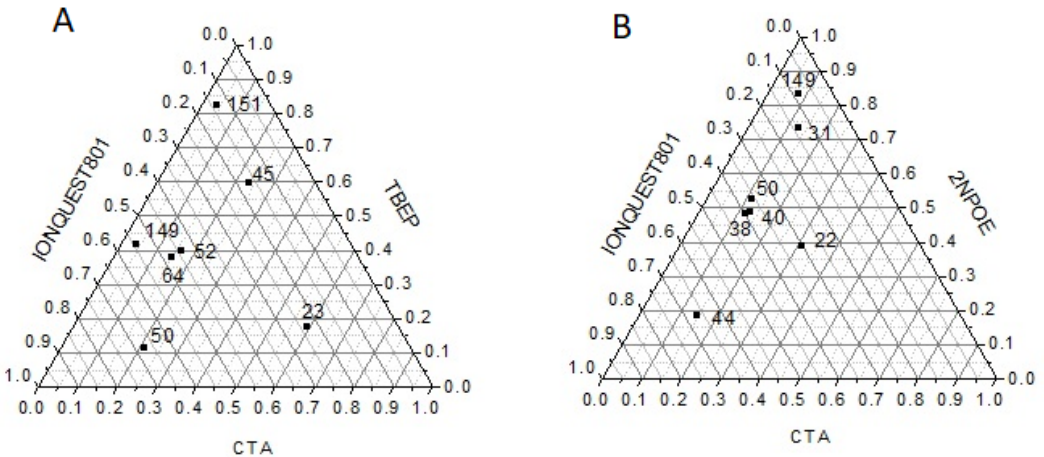
Figure 1. Ternary diagrams for PIMs formation using 2NPOE ( A ) and TBEP ( B ) as plasticizers. Black squares stand for a positive (+) membrane formation while red dots for a negative ( − ) one. Upper diagrams correspond to weight percent while lower diagrams to mole percent.